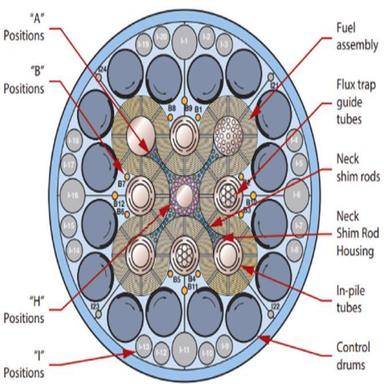
Shows a cross section of the ATR core with various irradiation positions and assemblies labeled.